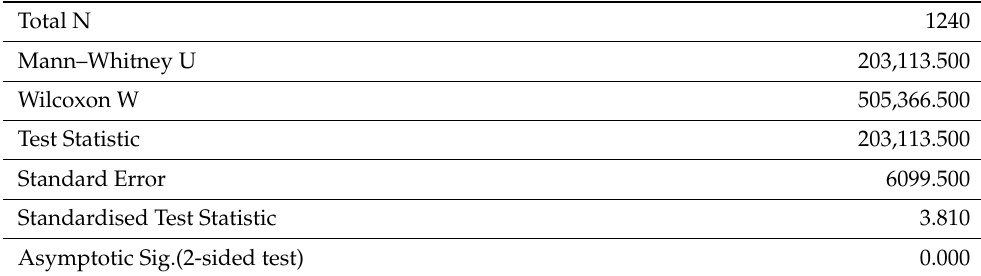
Independent-Samples Mann–Whitney U Test between functionalised and non- functionalised MSNs. The table shows the independent-samples Mann–Whitney U test results between functionalised and non-functionalised MSNs’ viability scores. p value lower than 0.05 indicates significant differences.